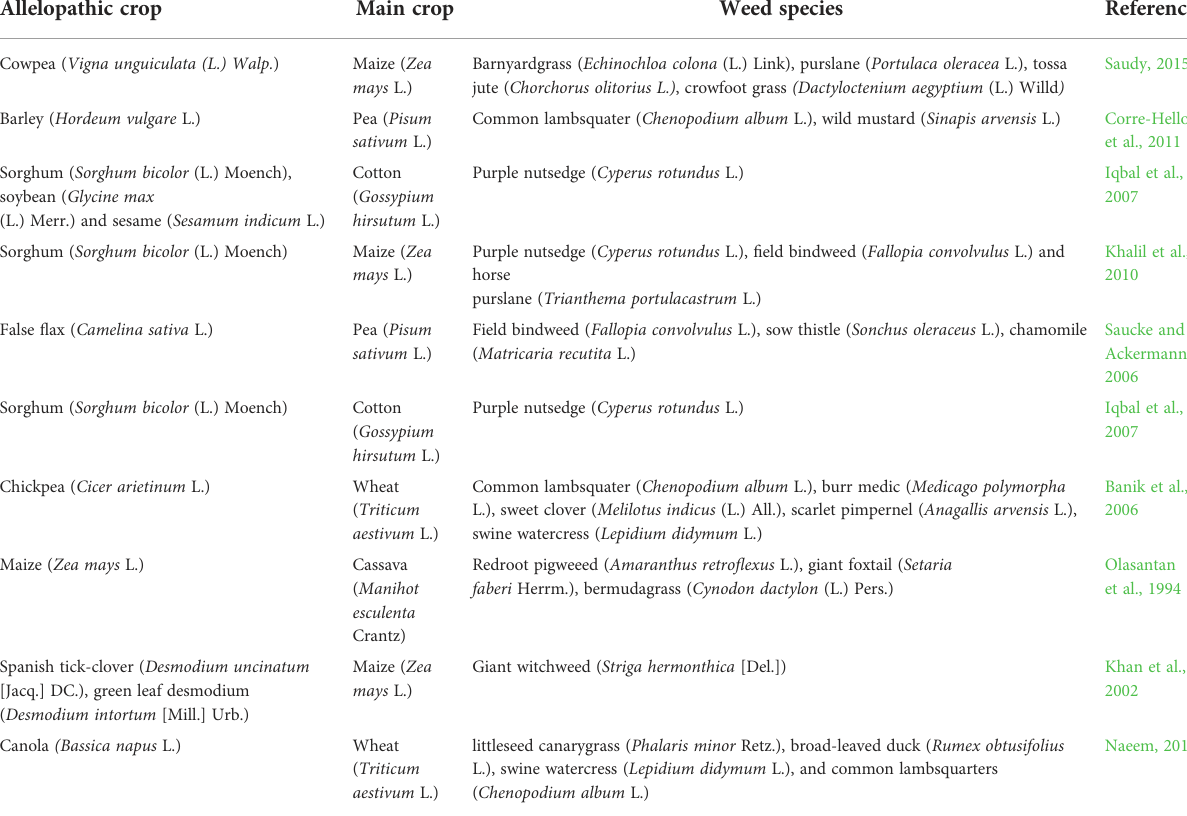
TABLE 2 Example of allelopathic crop and main crop intercropping